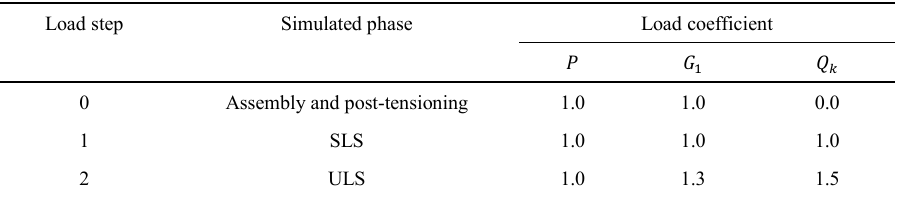
Table 2: Load step definition for the nonlinear